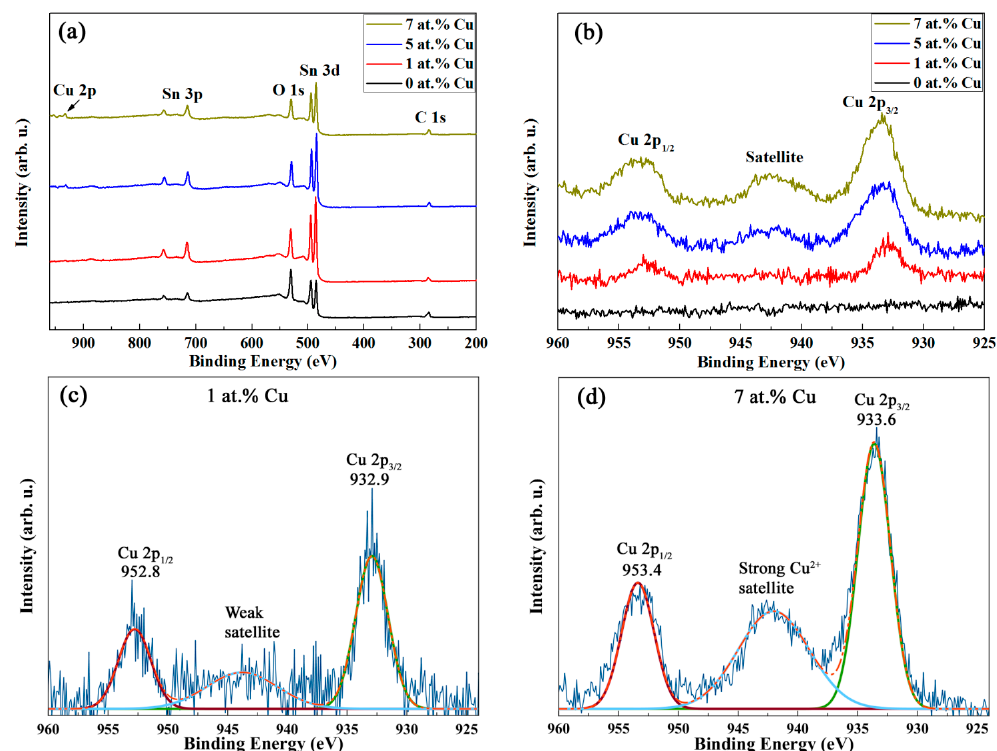
Figure 4. ( a ) General X-ray photoelectron spectroscopy(XPS) survey spectra of undoped and Cu-doped SnO 2 mesoporous powders. ( b ) High resolution XPS spectra of the Cu 2p level. ( c , d ) are the Cu 2p deconvolutions corresponding to the 1 and 7 at.% Cu SnO 2 samples, respectively.